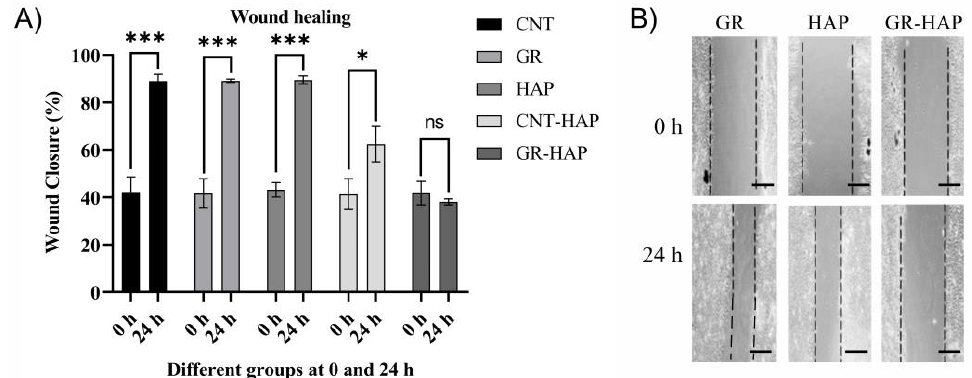
Figure 6. ( A ) Effect of CNTs, GR, HAP, CNTs-HAP, and GR-HAP on wound-healing capacity. Data are presented as means ± standard error of the mean of 4-5 independent experiments. ( B ) Representative images of wound healing following exposure to control GR, HAP, and GR-HAP. * p < 0.05, and *** p < 0.001 represents significant differences obtained from paired t -test, whereas ns = not significant. Scale bars measure 250 μ M.